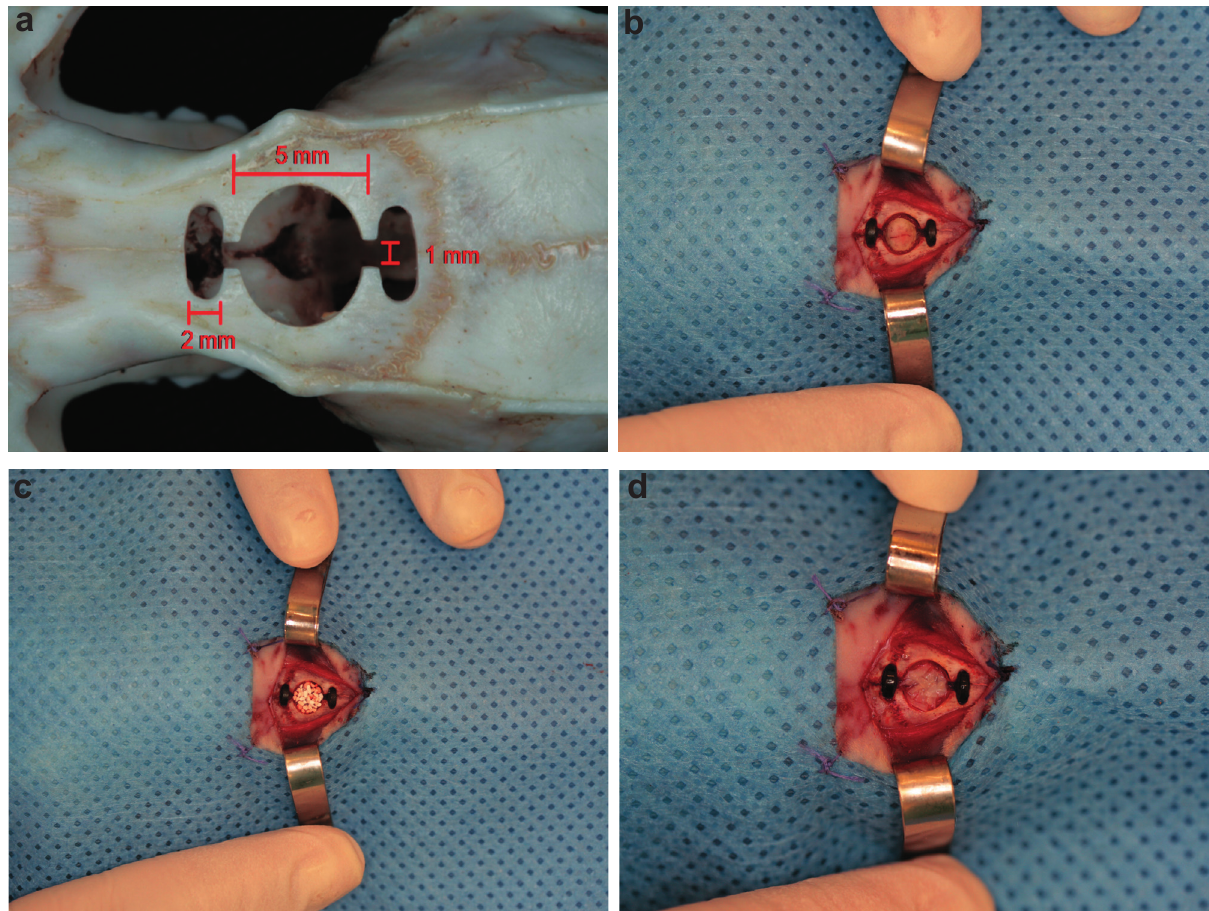
Figure 1- Reconstruction of critical bone defects in rat calvaria using different materials. a) Dimensions of critical bone defects; b) Reconstruction with autogenous bone graft; c) Reconstruction with powdered synthetic hydroxyapatite implant; d) Reconstruction with allogeneic cartilage